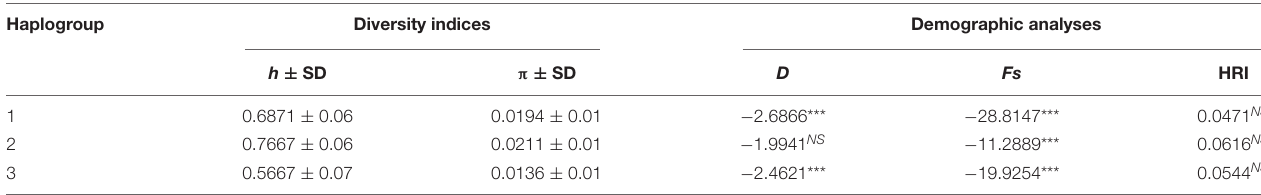
TABLE 4 | Diversity indices and results of demographic analyses used to test range expansion in Tridacna maxima for each haplogroup in the RSGA. Haplogroup Diversity indices Demographic